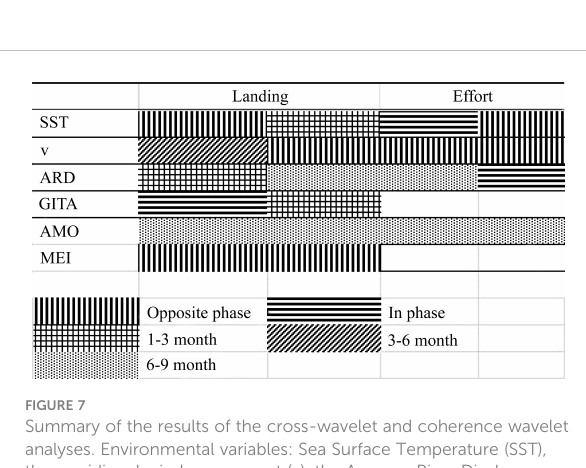
FIGURE 7 Summary of the results of the cross-wavelet and coherence wavelet analyses. Environmental variables: Sea Surface Temperature (SST), the meridional wind component (v), the Amazon River Discharge (ARD), Atlantic Ocean Inter-hemispheric Sea Surface Temperature Gradient Index (GITA), Atlantic multidecadal oscillation (AMO), and Multivariate ENSO Index